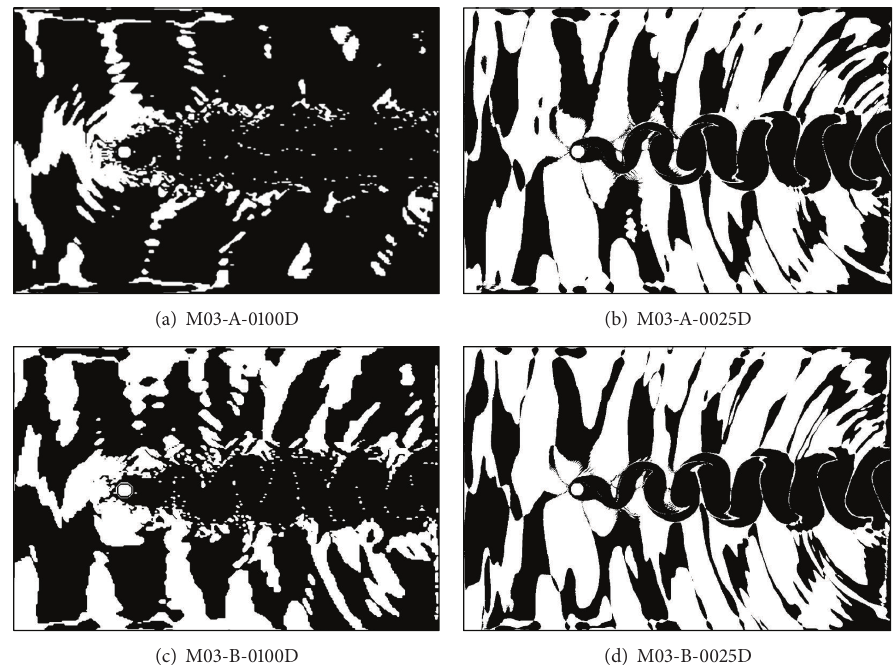
Figure 10: Visualization of switching parameter 𝛽 (white: 𝛽 = 1, black: 𝛽 = 0).